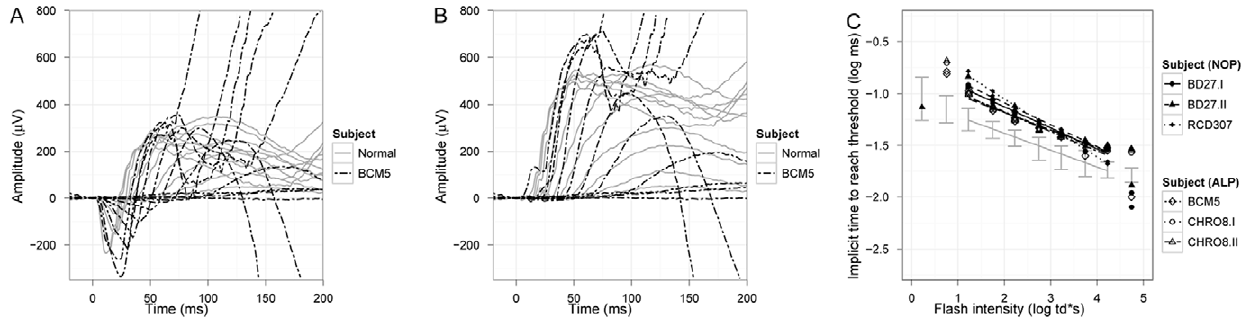
Figure 6. Analysis of the P II response. Overlaid representative scotopic waveforms of a normal subject (grey lines) and patient BCM5 (chain lines) and the extracted P II components (B) are presented. The delay in implicit times to reach a threshold amplitude of 50 m V at each intensity level is plotted in a log-log diagram both for the NOP group and ALP group (C).